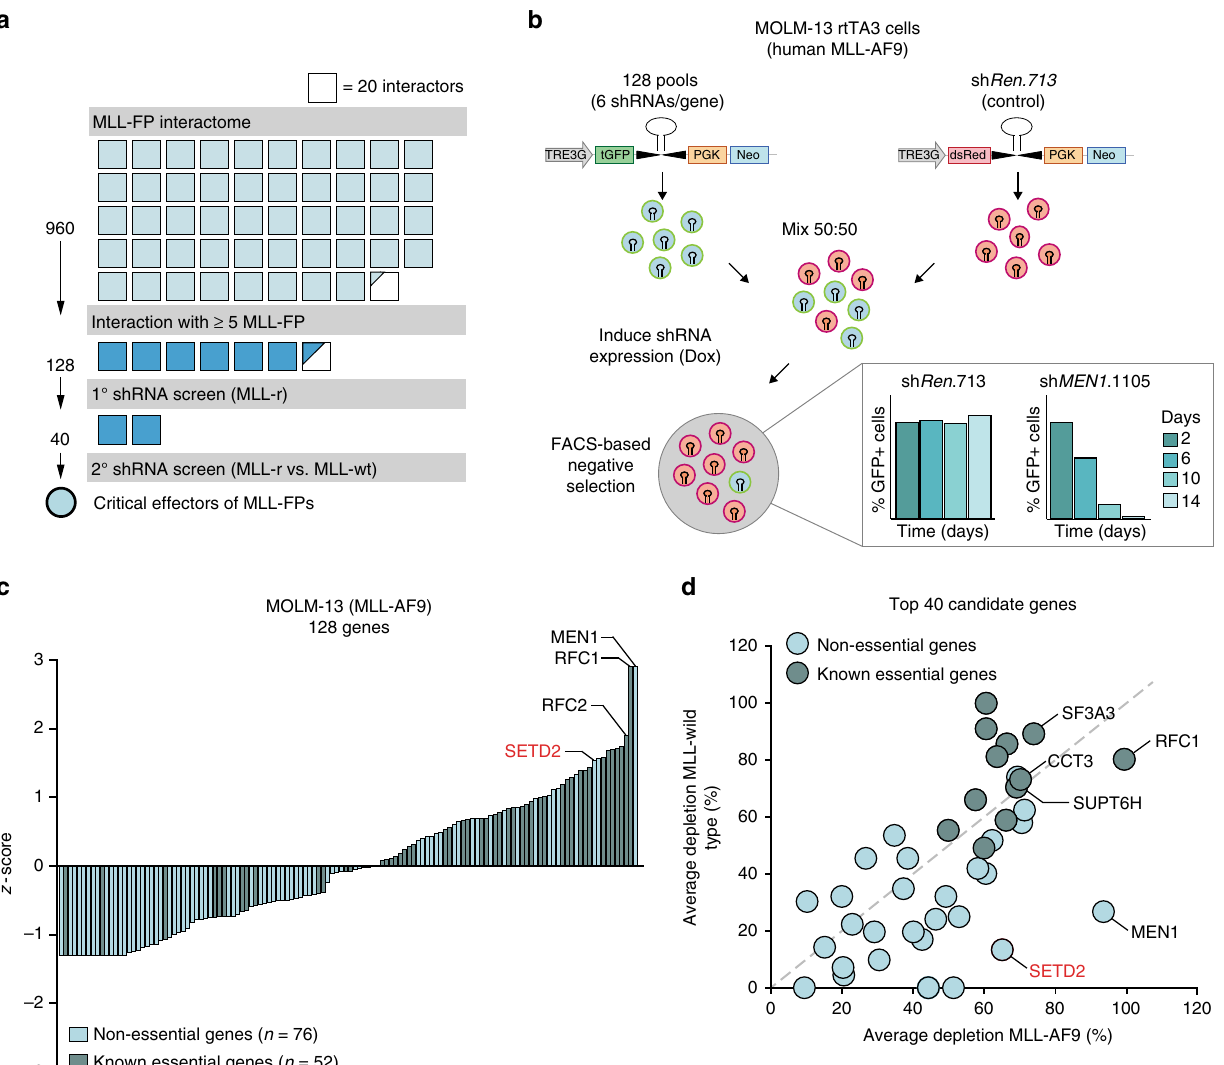
Fig. 2 shRNA screen identi fi es SETD2 as a critical effector of MLL-fusions. a Schematic representation of the fi ltering strategy. Af fi nity puri fi cation coupled to mass spectrometry identi fi ed 960 candidate genes (top 300 interactors per bait, ranked by p -value) to interact with at least one of seven selected MLL- fusion proteins. 128 proteins interacted with ≥ 5 of seven MLL-fusions. 40 candidate genes were screened in MLL-rearranged vs. MLL-wild-type cell lines. Each square corresponds to 20 interactors. b Schematic outline of retroviral vectors and experimental design of the FACS-based negative selection RNAi screen. Competitive proliferation assays were set up by mixing cells in a 50:50 ratio (experimental-GFP vs. control-dsRed) and cultivation in the presence of Dox. The relative ratio of GFP-positive vs. dsRed-positive cells was monitored by fl ow cytometry over 14 days. Bar graphs (bottom) represent the performance of positive (sh MEN1 .1105) and negative (sh Ren .713) controls shown as percentage of GFP + cells over time. c Summary of RNAi screening data in the MOLM-13 cell line. Positive and negative z -scores correspond to candidate genes with stronger and weaker depletion phenotypes. Gene essentiality was assigned based on published datasets. d Average depletion values obtained from two subsequent RNAi screens performed in the MLL- AF9-expressing MOLM-13 cell line are plotted against mean depletion values from counterscreens performed in two MLL-wild-type cell lines (K562 and